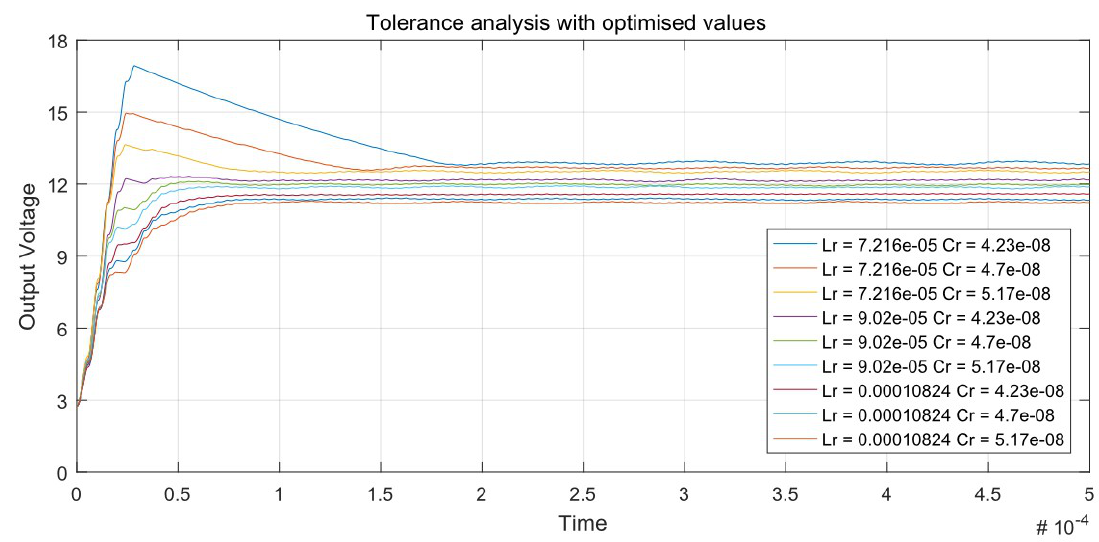
Figure 16. Tolerance analysis of the transient response of the output voltage with optimized values.